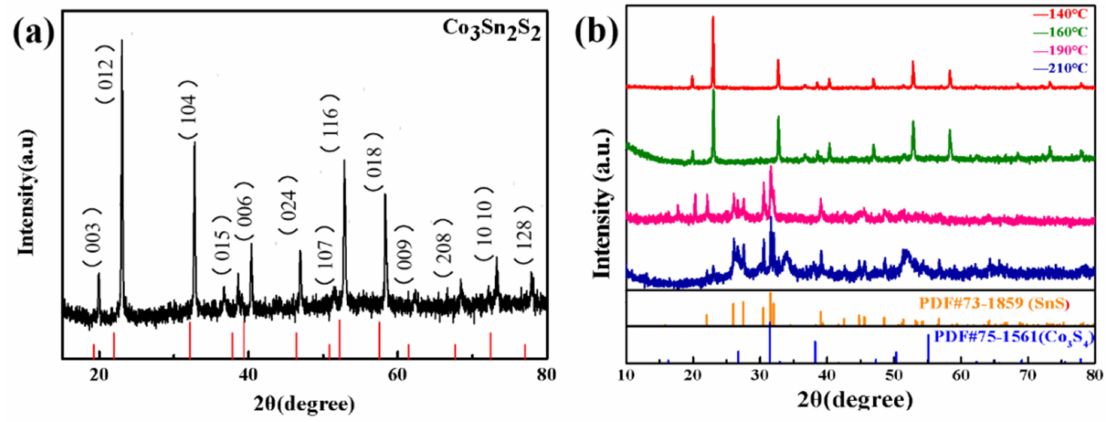
Figure 3. ( a ) XRD patterns of Co 3 Sn 2 S 2 ; ( b ) XRD patterns of Co 3 Sn 2 S 2 at different reaction